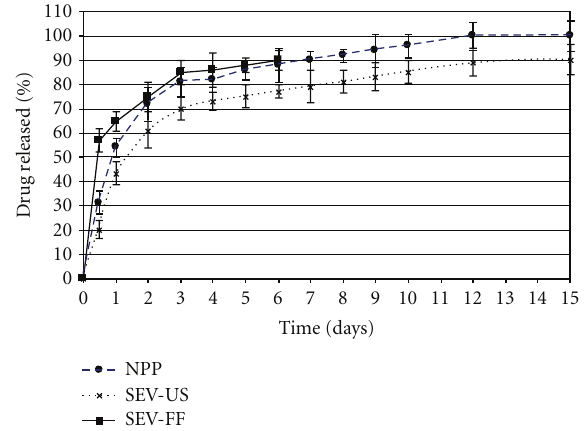
Figure 5: Drug release profile from nanoparticles prepared by three di ff erent methods: NPP, SEV-US, and